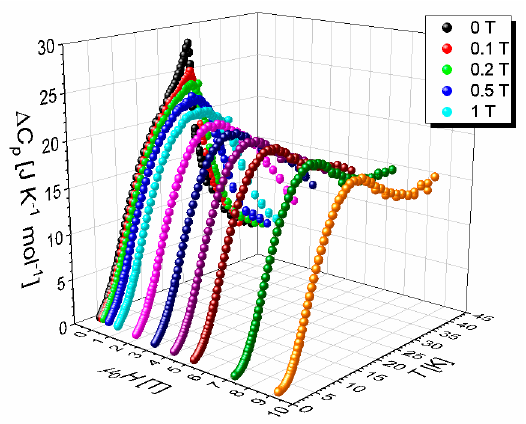
Figure 10. Magnetic excess heat capacity of 2 .